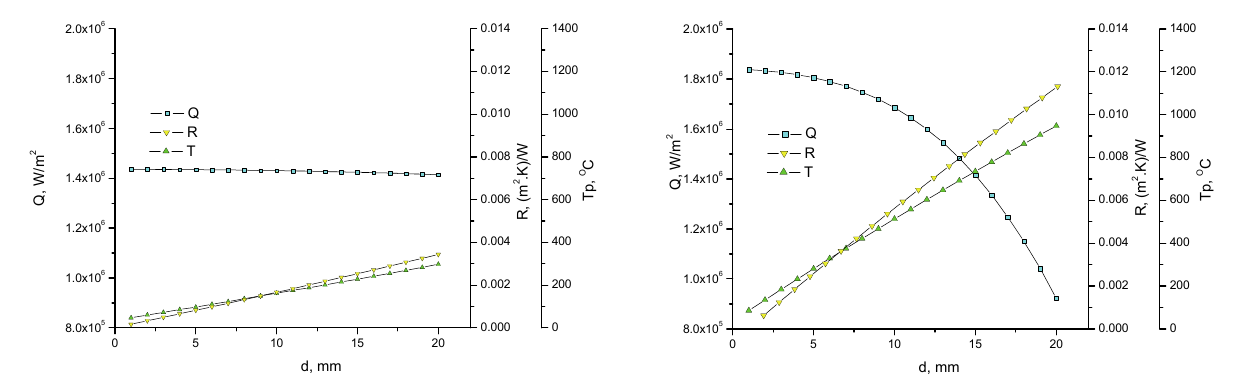
Figure 4: Heat losses, surfaces temperature and thermal resistance of insulation as a function of silica insulation thickness